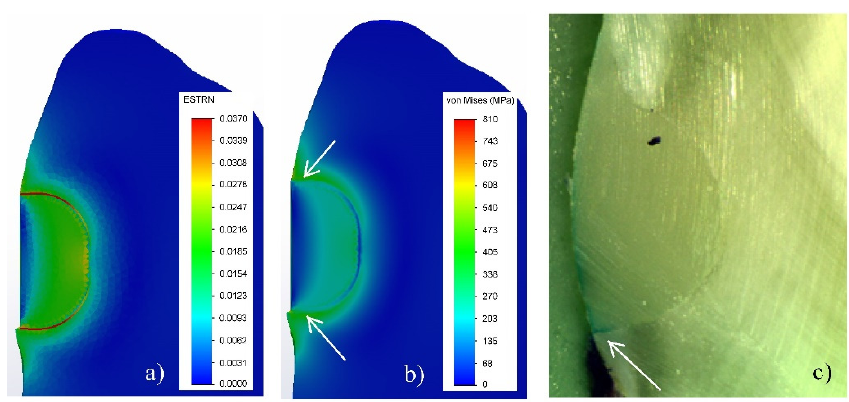
Figure 7. Filling of tooth cavity made with FPC: ( a ) Strain in the zone of filling; ( b ) Von Mises equivalent stresses; ( c ) Micro-leakage. (3% shrinkage).